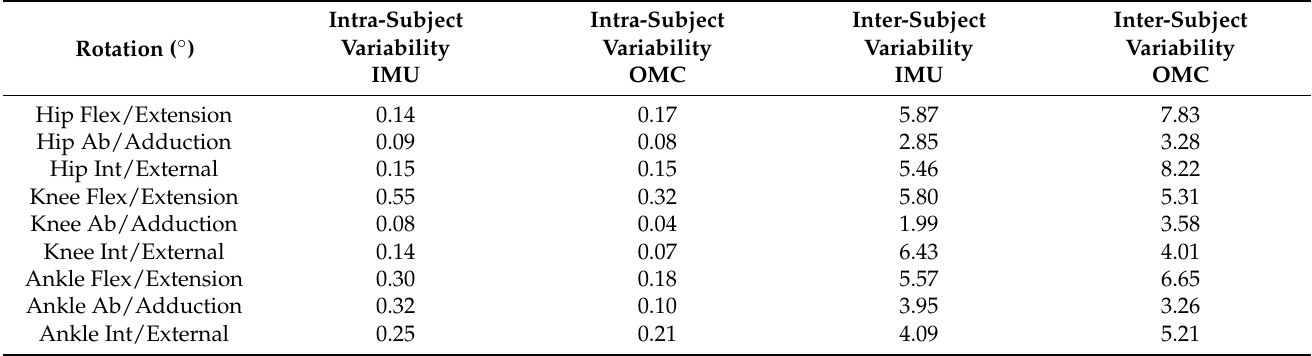
Table 2. Average intra-subject variability and inter-subject variability over the sound gait cycle among the thirty participants for both